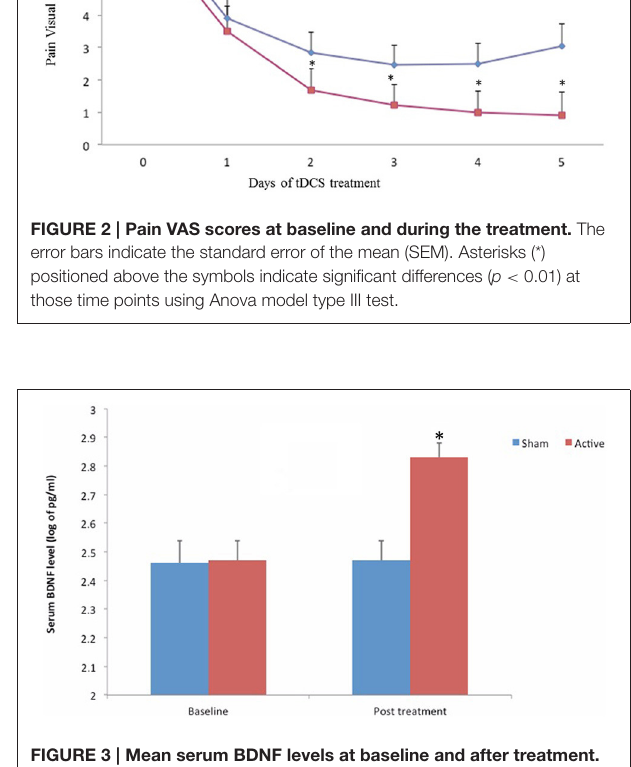
FIGURE 3 | Mean serum BDNF levels at baseline and after treatment. Asterisk ( * ) positioned above the symbols indicate significant differences ( p < 0.01 ).